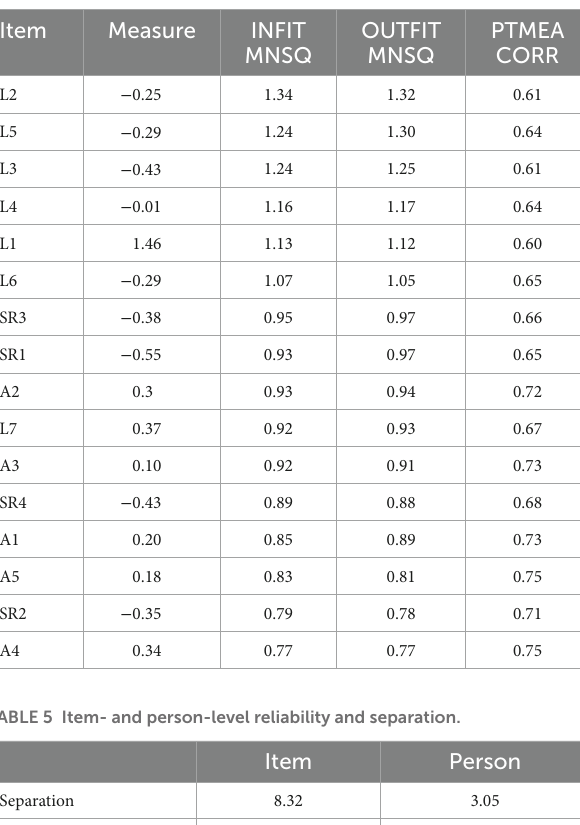
TABLE 4 Item statistics: misfit order.